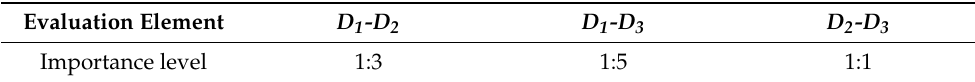
Table 5. Data from expert’s answers to questionnaire. Evaluation Element